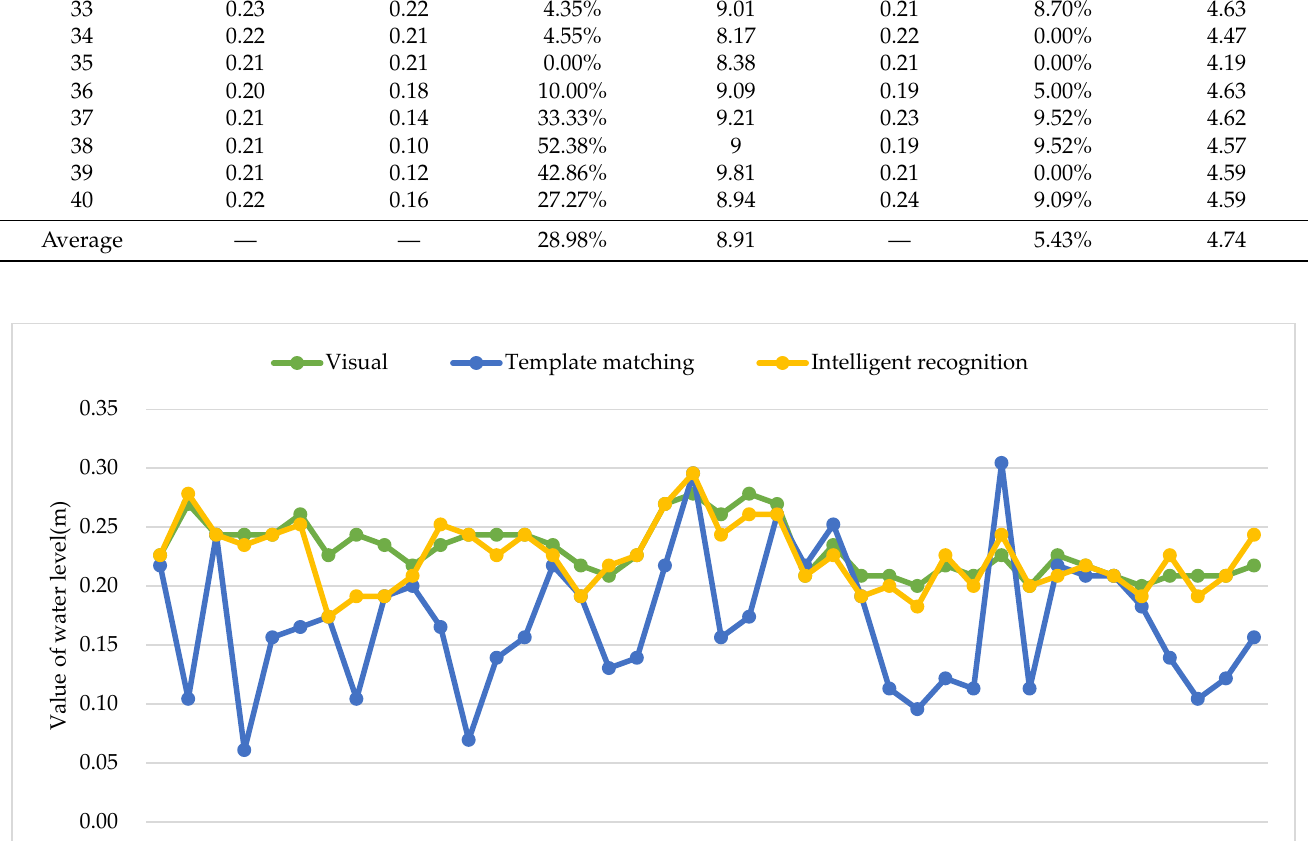
Figure 22. Comparison of water level values. The green line shows the values by visual reading. The yellow line represents the values of intelligent recognition. The bule line represents the values by the method of template matching. The abscissa represents the sequence number of the image and the ordinate represents the value of the reading (the unit is m).